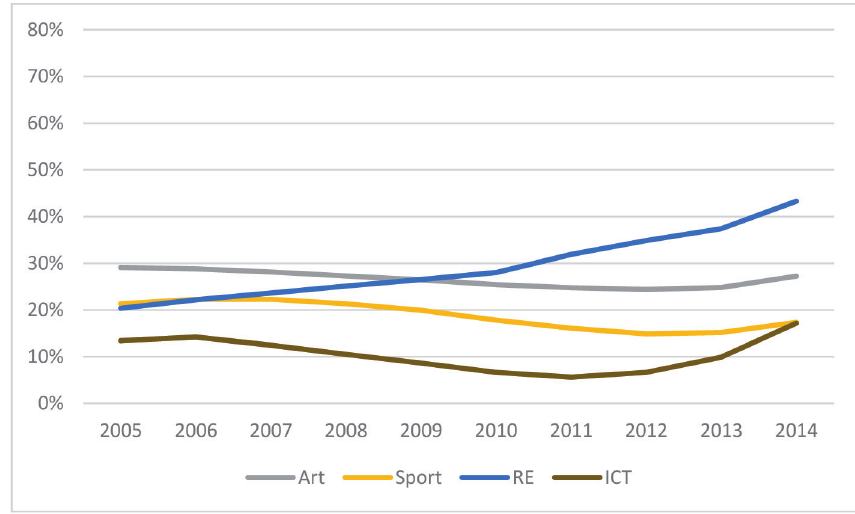
Figure 6: Percentage of pupils entered in GCSEs in art and design, ICT, PE/sport studies, and